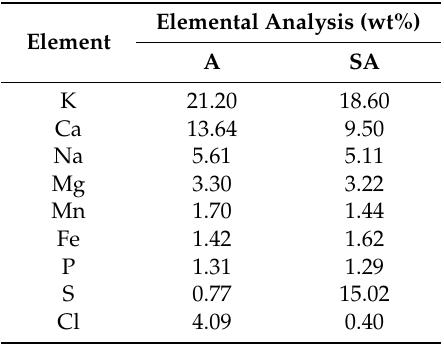
Table 1. Elemental analysis of ash.